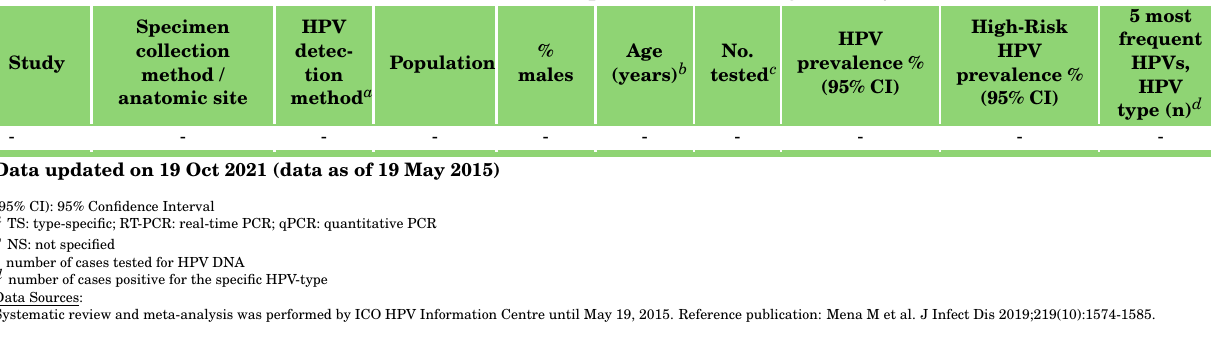
Table 35: Studies on oral HPV prevalence among healthy in